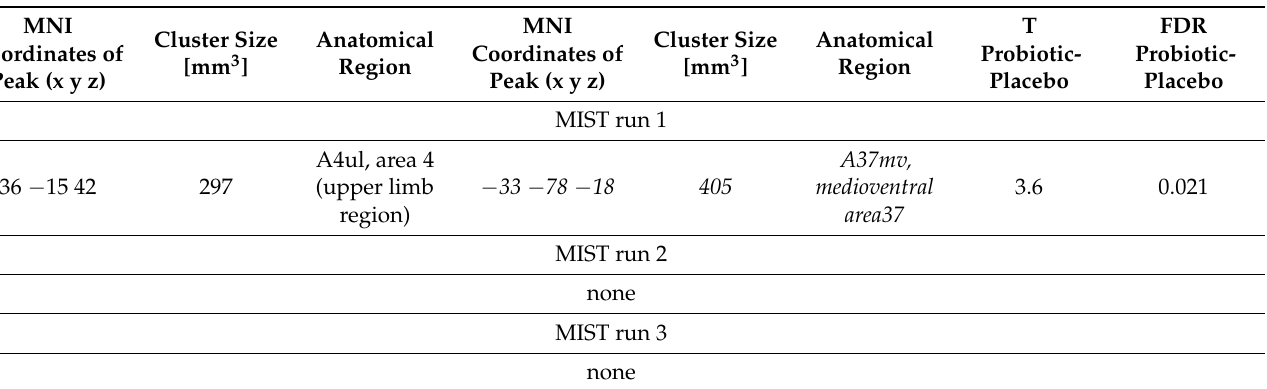
Table 3. Clusters that were found to be associated with significant functional connectivity changes between both interventions during the MIST paradigm. One of these clusters covered a predefined ROI (italic).